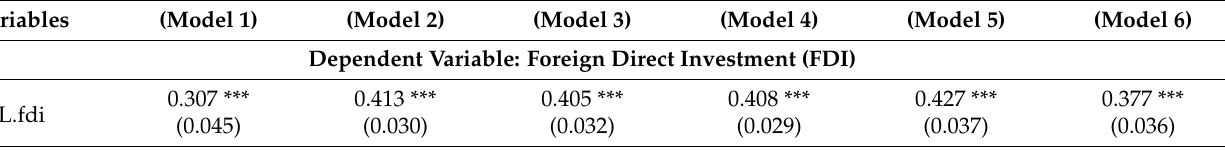
Table 4. Empirical estimates of the relationship between infectious diseases and FDI (using